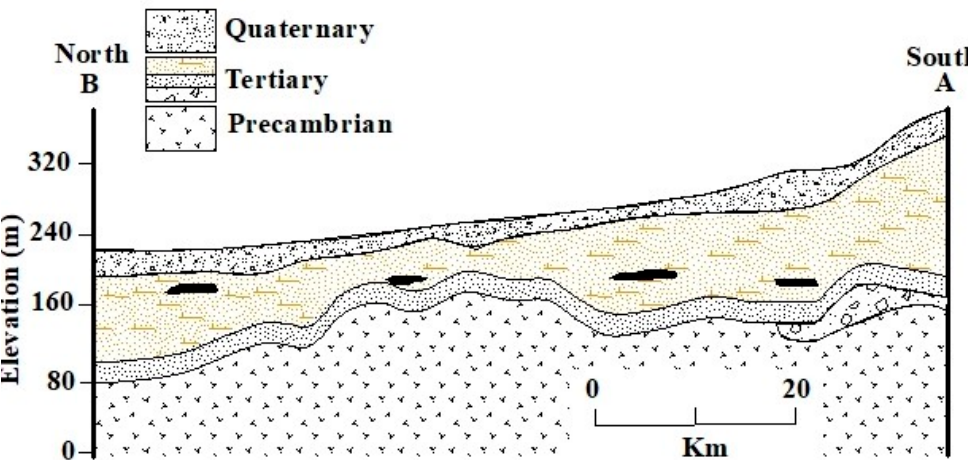
Figure 3. Representative south–north oriented cross-section of the study area showing the main geological units (Modified from Reference [48]).